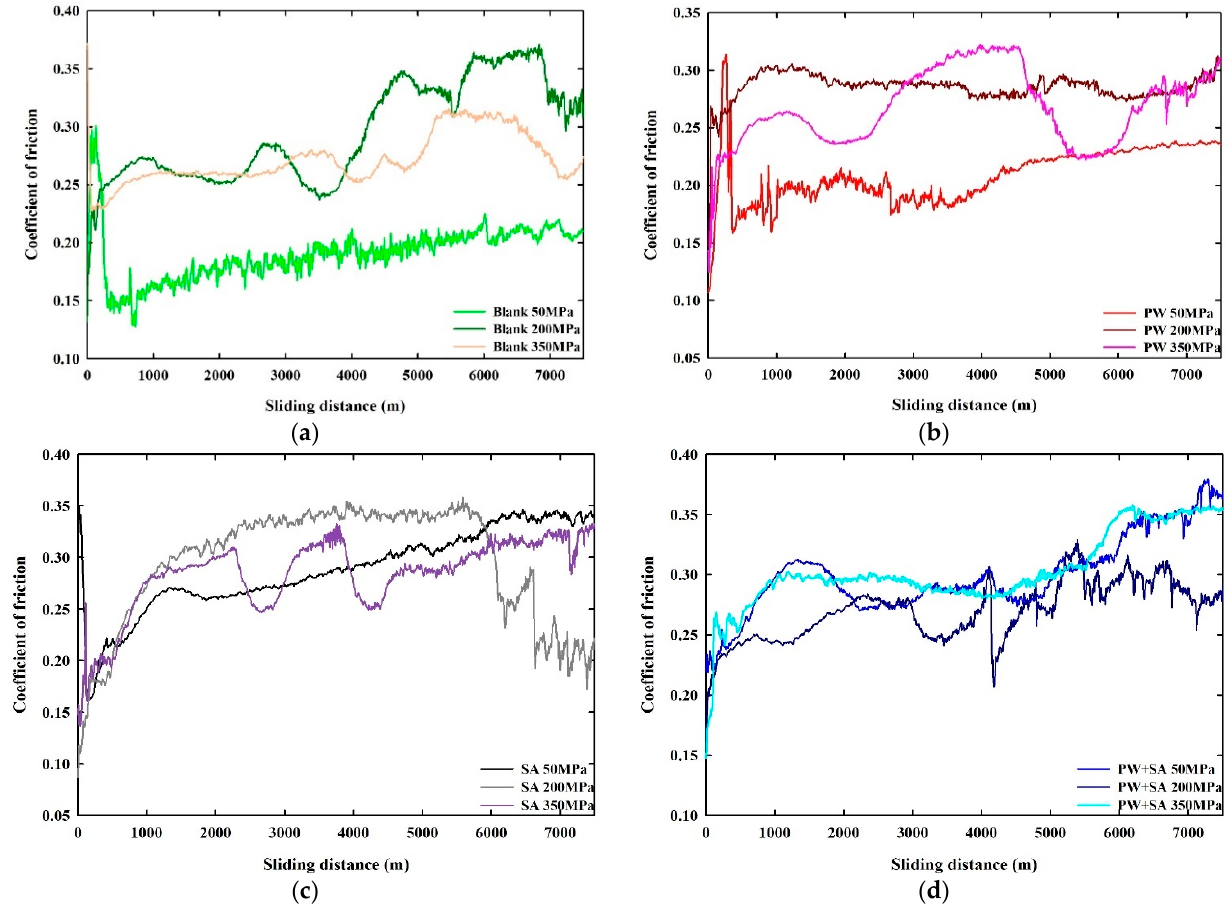
Figure 10. Effect of compaction pressures on coefficients of friction µ as a function of sliding distance for sintered Cu–15Fe samples: ( a ) blank, ( b ) PW, ( c ) SA, and ( d ) PW+SA.